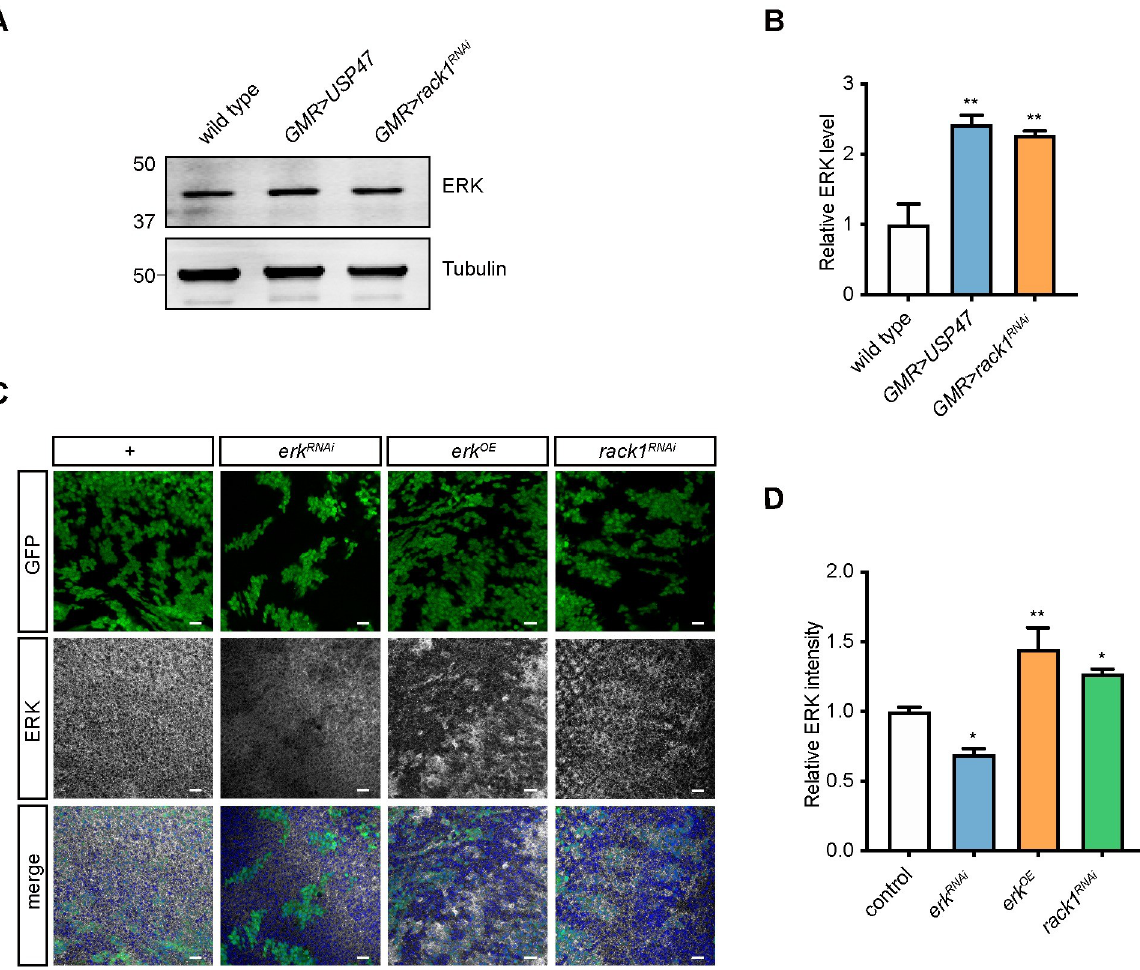
Fig 5. Knocking down rack1 increased ERK levels. (A) Western blot analysis of proteins extracted from eyes of wild-type ( GMR-GAL4/+